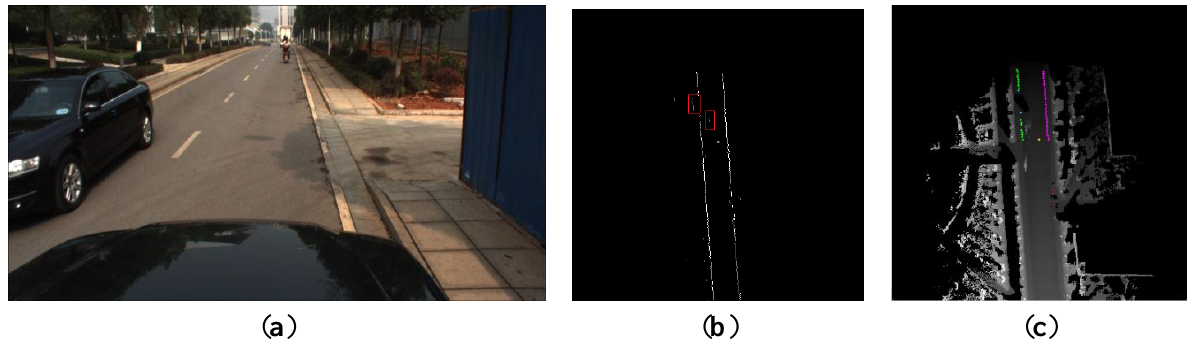
Figure 13. The curb detection in typical dynamic environment. ( a ) Scene 3. ( b ) The accumulated results of the curb candidates. ( c ) The final curb detection results in the local